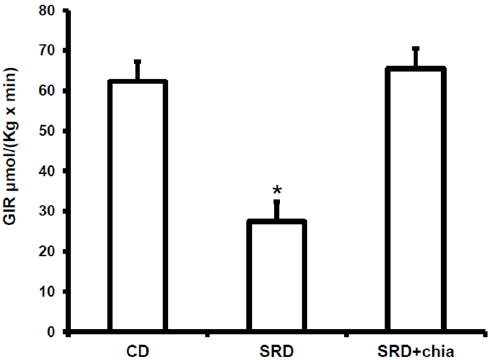
Values are mean, with their standard errors depicted by vertical bars (six animals per group).* p < 0.05 SRD vs. CD and SRD + chia. 0.05 SRD vs. CD and SRD + chia. Figure 1. GIR during euglycemic-hyperinsulinemic clamp in rats fed a control diet (CD), sucrose-rich Figure 1. GIR during euglycemic ‐ hyperinsulinemic clamp in rats fed a control diet (CD), sucrose ‐ rich diet (SRD) or SRD + chia seed (SRD + diet (SRD) or SRD + chia seed (SRD + chia).